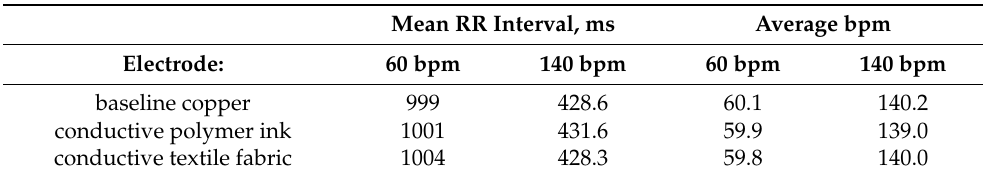
Table 1. RR interval comparison of the mannequin simulated signal for each electrode case for a 60 bpm and 140 bpm generated test signal.